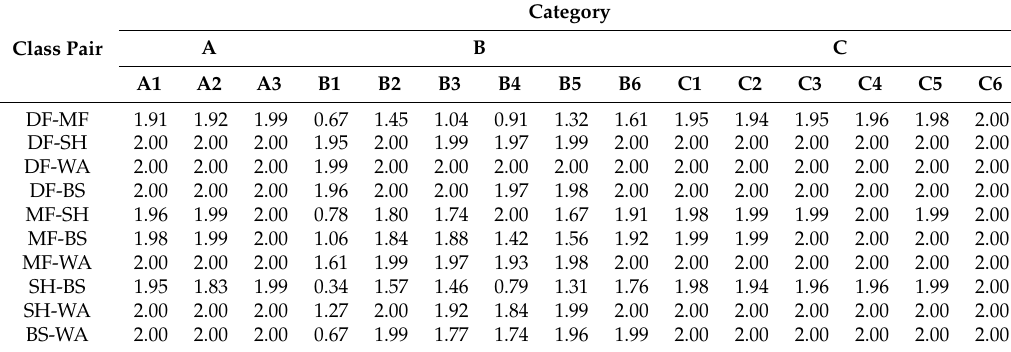
Table 6. Training samples separability values for various land cover class pair for all classification scenarios (A–C) (Table 5) based on Jeffries-Matusita (J-M) sparability index. WA: Water, DF: Dense